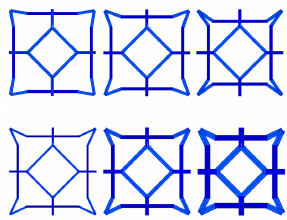
Figure 3. Top: The affect of increasing re-entrant angle on the design of the unit cell (from left to right). Bottom: The affect of increasing relative density on the design of the unit cell (from left to